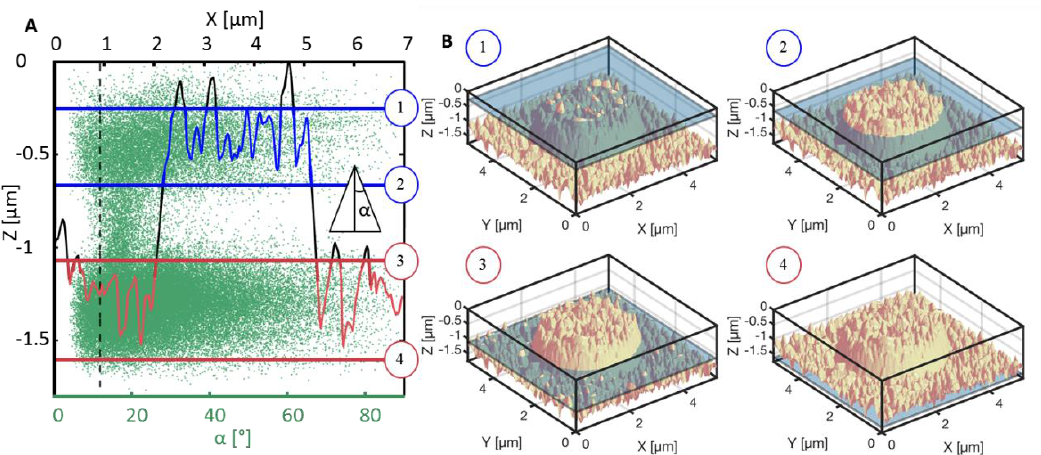
Figure 4. ( A) The half-opening angles as the function of the depth into the pattern. The green dots represent the distribution of all half-opening angles α across the AFM measured hierarchical surface (the bottom horizontal axis). The black line shows one one-dimensional (1D) cut through the middle of the pillar pattern (the top horizontal axis). The blue lines highlight the top part of the nano-grass pattern, where the half-opening angle is below 12°, where the wetting should not be able to take place. The red lines show the bottom part of the nano-grass pattern, where the opening angles are below 12°, which is another place where further wetting should not be possible. The three-dimensional (3D) representation of the mentioned critical areas of the pattern marked in blue and red are shown in ( B ) 1–2 and 3–4 respectively. Compared to the results in Table 1 and Figure 3, the wetting level should correspond to the situation in B2, where the water has wetted the top layer of the nano-grass pattern but does not yet touch the nano-grass carpet between the